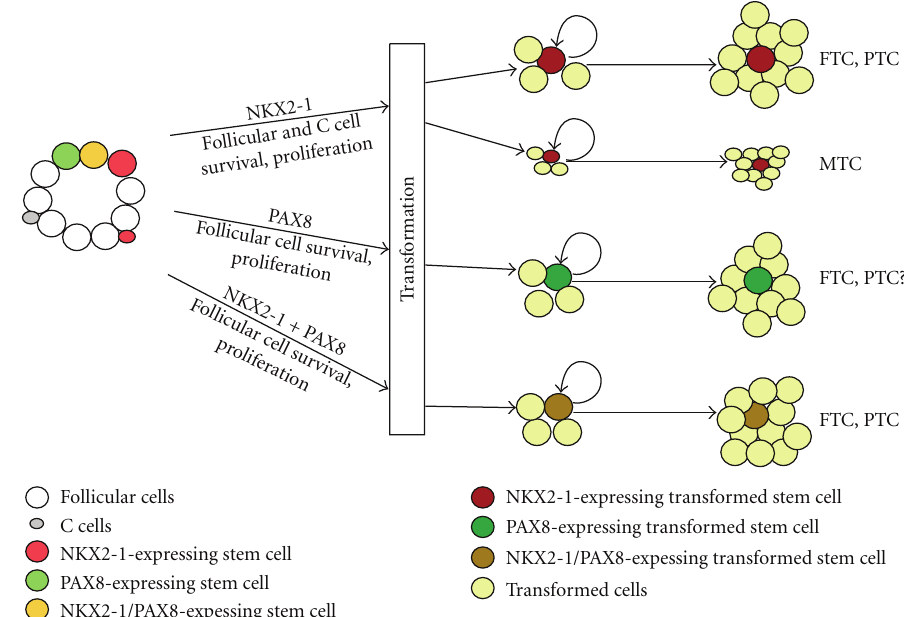
Figure 1: Possible involvement of NKX2-1 and/or PAX8 in the maintenance and/or activity of stem cells of the thyroid. Transformation of NKX2-1 and/or PAX8-expressing stem cells leads to thyroid cancer. Transformed NKX2-1 and/or PAX8-expressing stem cells self-renew and proliferate to produce cancer. Upon becoming tumorigenic, most of transformed cells may lose NKX2-1 and/or PAX8 expression. FTC: follicular thyroid carcinoma, PTC: papillary thyroid carcinoma, and MTC: medullary thyroid